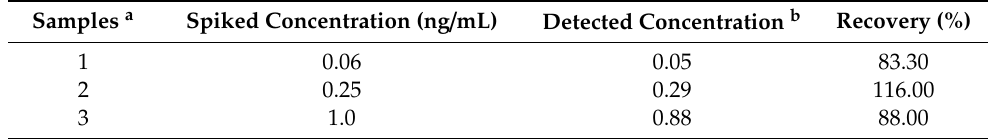
Table 2. Recoveries of NP from spiked human serum samples.